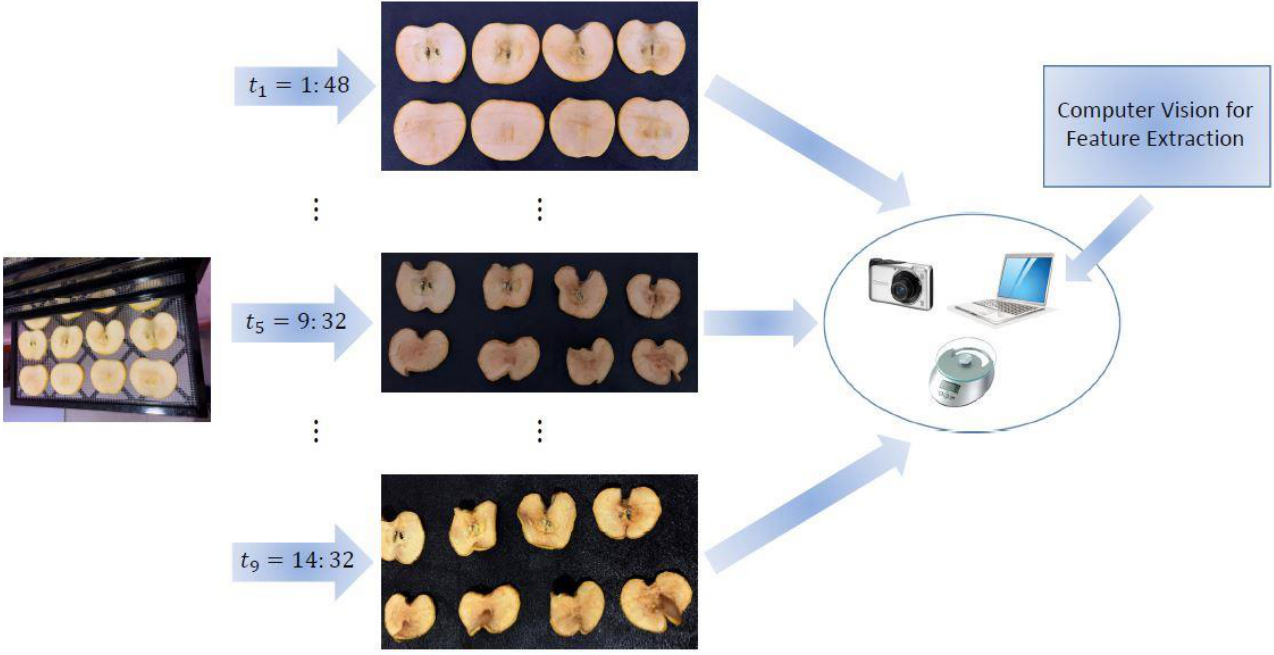
Figure 1. General overview of the computer vision methodology.